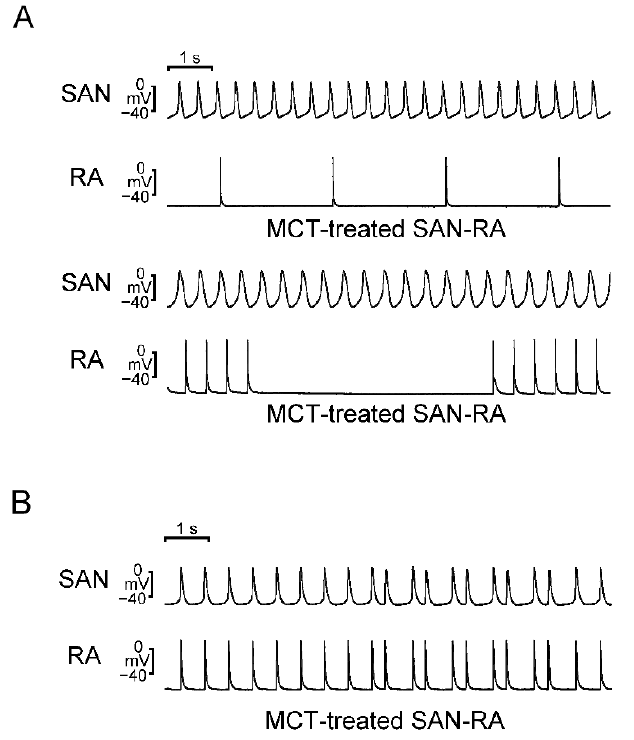
Figure 4. Conduction block and premature atrial beats with retrograde conduction in the sinoatrial node (SAN) – right atrium (RA) preparations from monocrotaline (MCT)-treated rabbits recorded by the conventional glass electrode. ( A ) Representative recordings of the conduction block from the SAN to the RA presented with a 6:1 conduction block (upper panel) or a long pause (lower panel). ( B ) Representative recordings of premature atrial beats with retrograde conduction from the RA to the SAN.